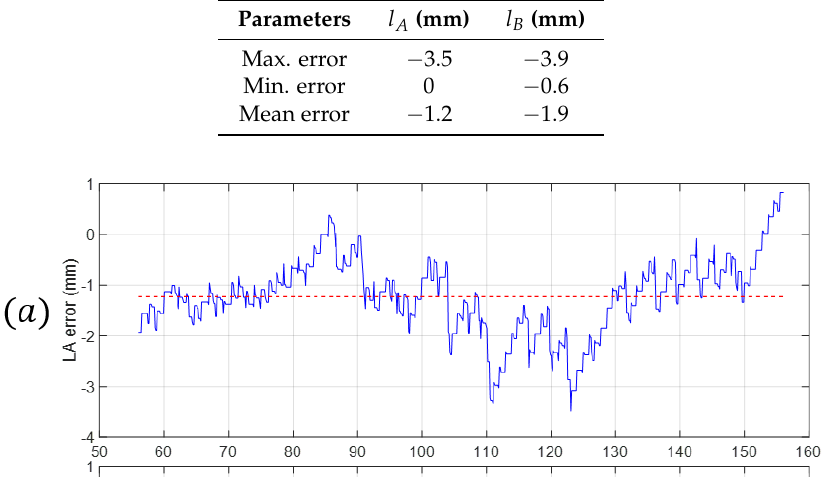
Table 9. Deviation from simulated and real measures.